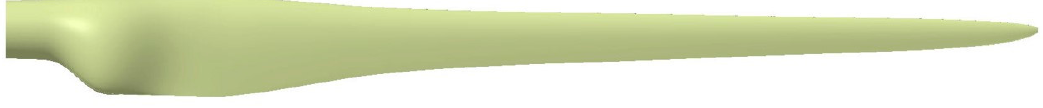
Figure 2. The aerodynamic shape of the blade.